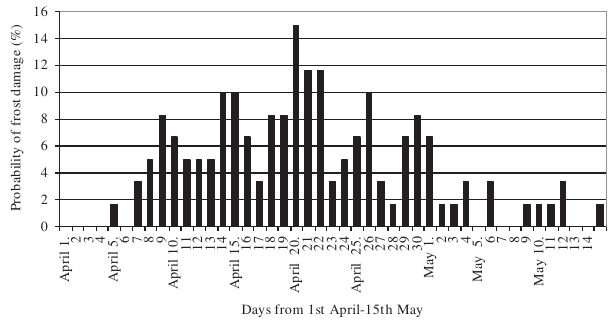
Figure 8 – Probability of suffering frost during blooming in